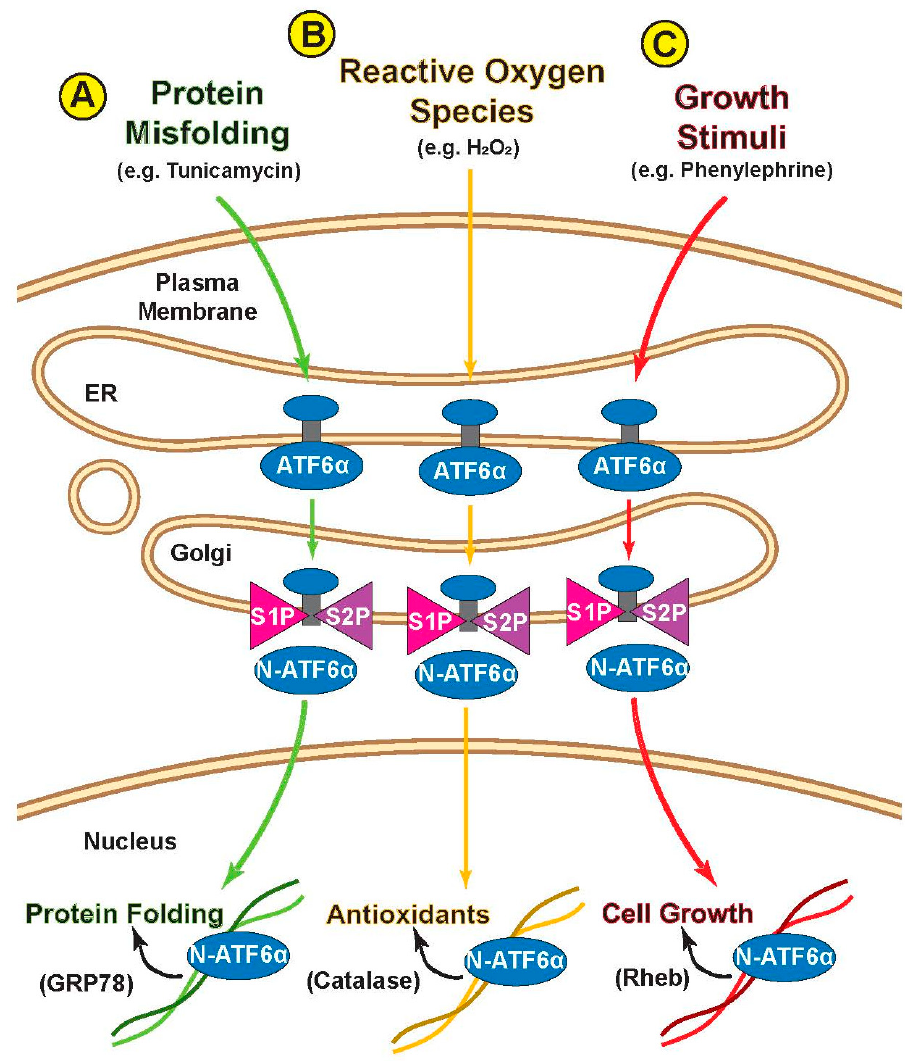
Figure 4. Stimulus-specific transcriptional programs for ATF6 α . Di ff erent stimuli cause ATF6 α to induce di ff erent transcriptional targets, depending on the stimulus, despite activating ATF6 α in apparently similar ways. ( A ) N-ATF6 α induces canonical ER chaperone GRP78 in response to protein misfolding; ( B ) N-ATF6 α upregulates antioxidant catalase, but only in response to oxidative stress; ( C ) N-ATF6 α upregulates cell growth inducer Rheb, but only in response to growth